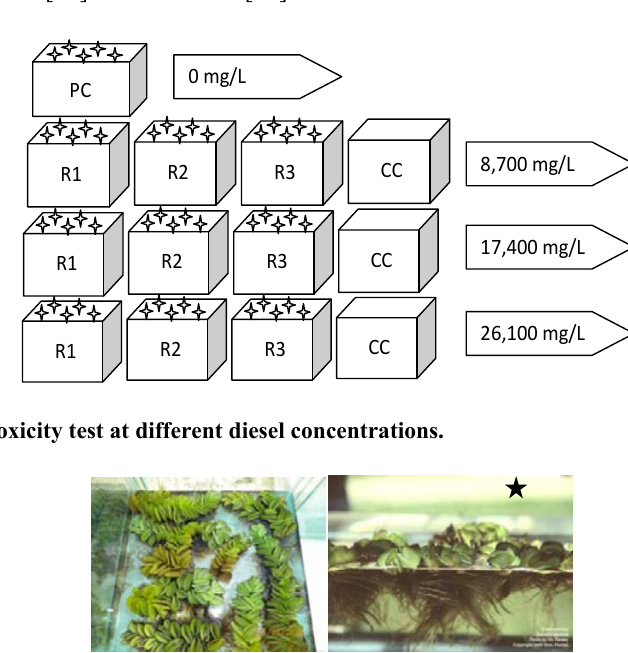
Fig. 2. The aquatic plant of Salvinia molesta